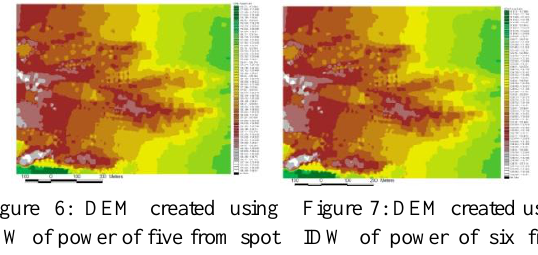
Figure 6: DEM created using IDW of power of five from spot elevation measurements.